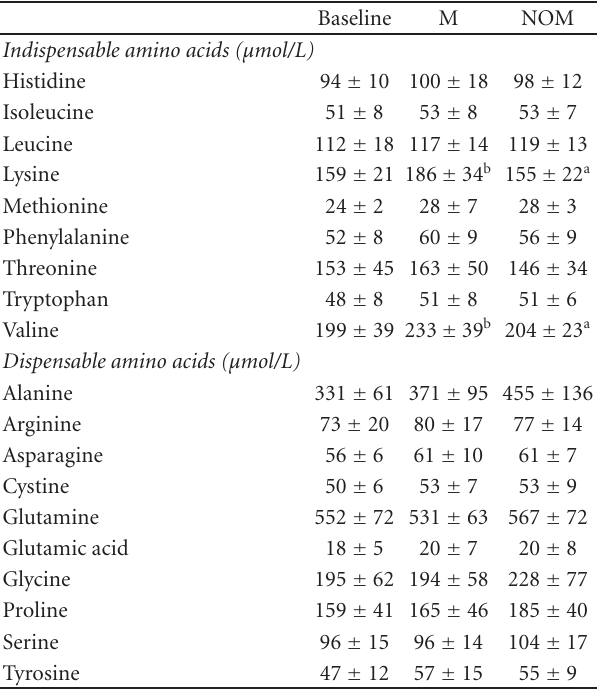
Table 5: Fasting plasma free amino acid concentrations of women at baseline and after 4 weeks periods of either additional meat consumption (M, 200g pork fillet/d) or exclusion of meat products (NOM).